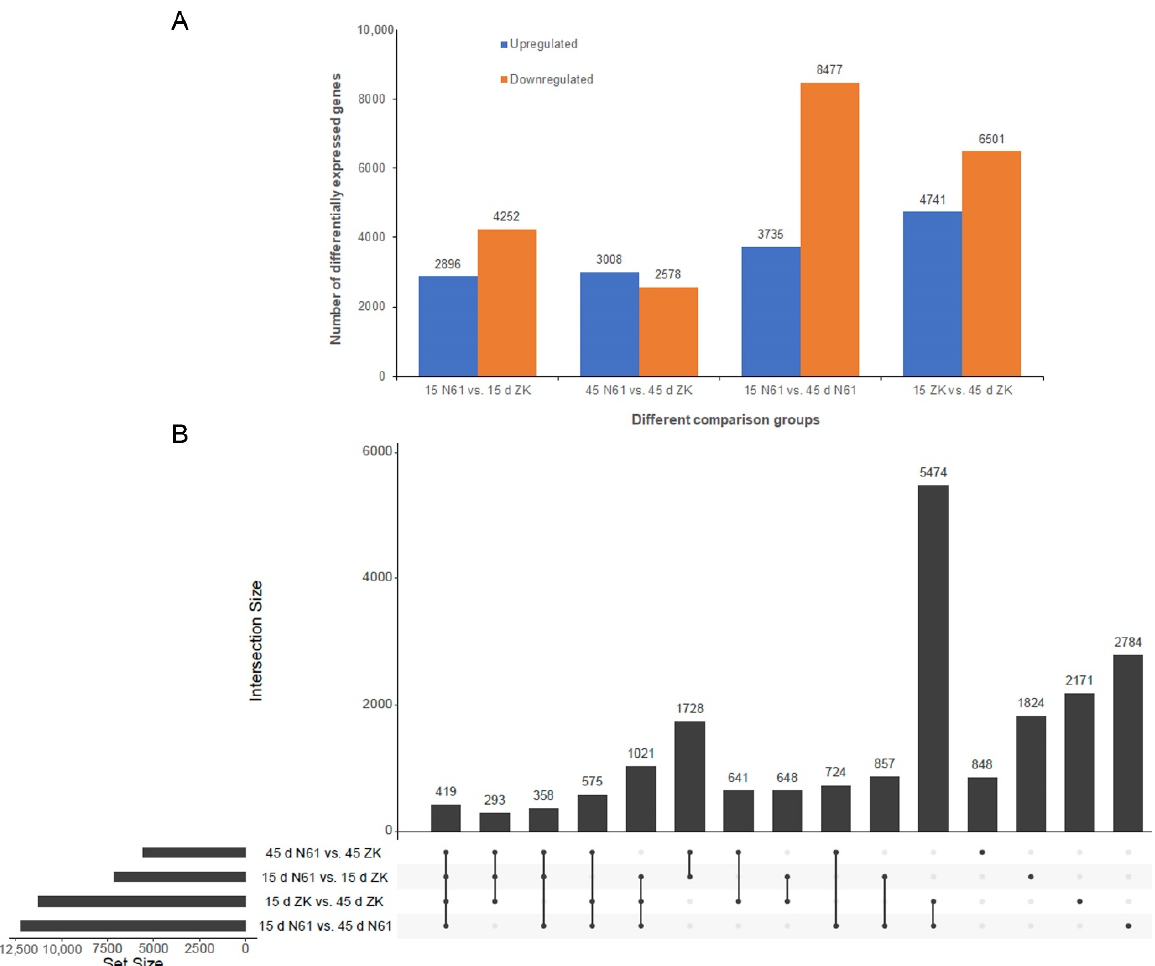
Figure 3. Analysis of differentially expressed genes between the 15- and 45-day stages of the Zikui (ZK) and N61 cultivars. ( A ) Numbers of differentially expressed genes. ( B ) UpSet graphs.